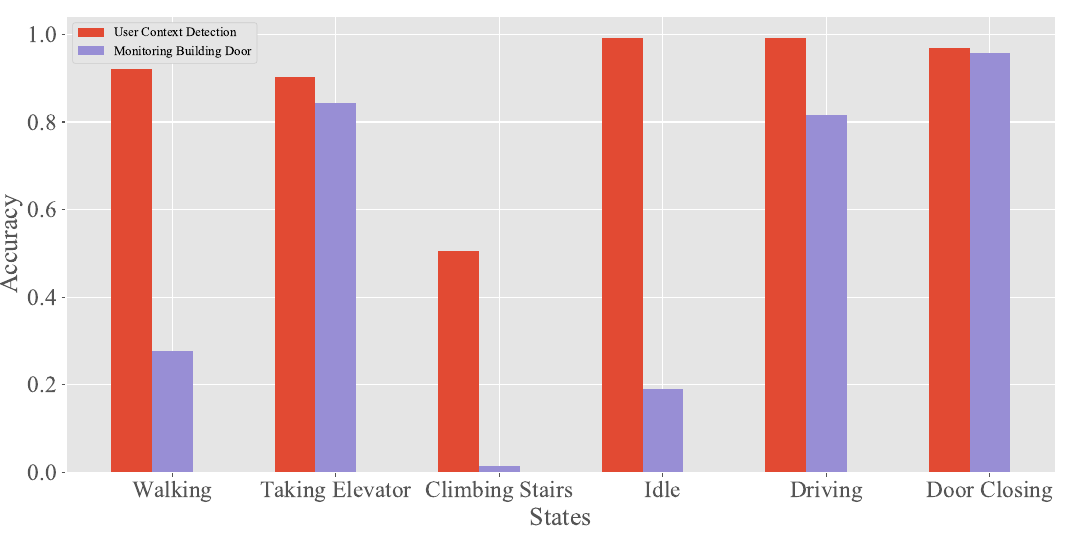
Figure 7. The detection comparison between the UCD and the monitoring building door (MBD).